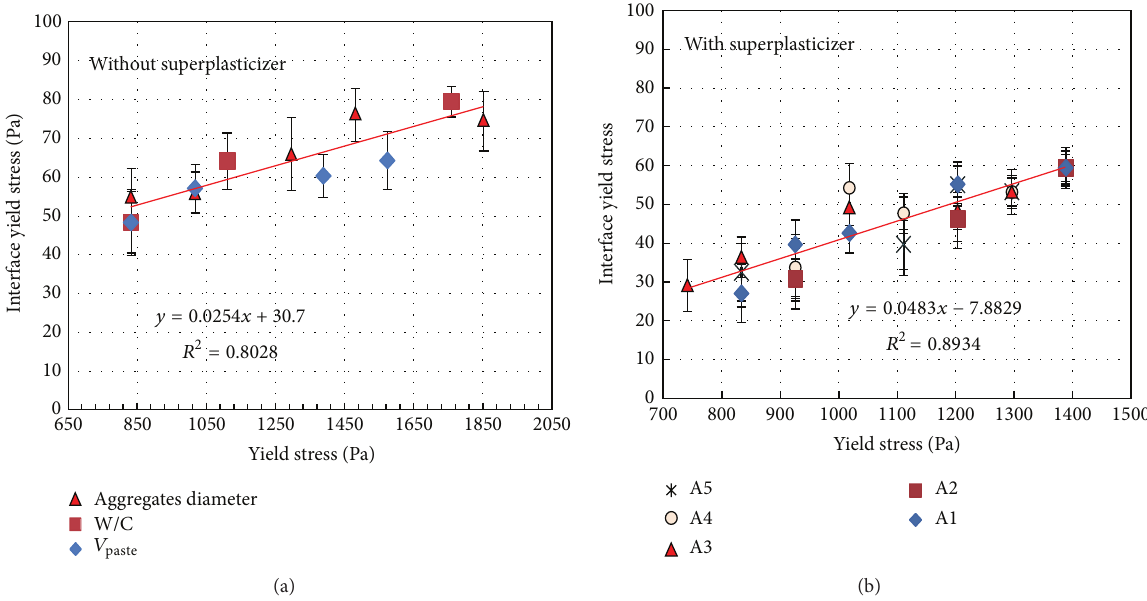
Figure 11: Evolution of the interface yield stress 𝜏 0𝑡 according to the concrete yield stress 𝜏 0 calculated by (12): (a) concretes series without superplasticizer and (b) concretes series with